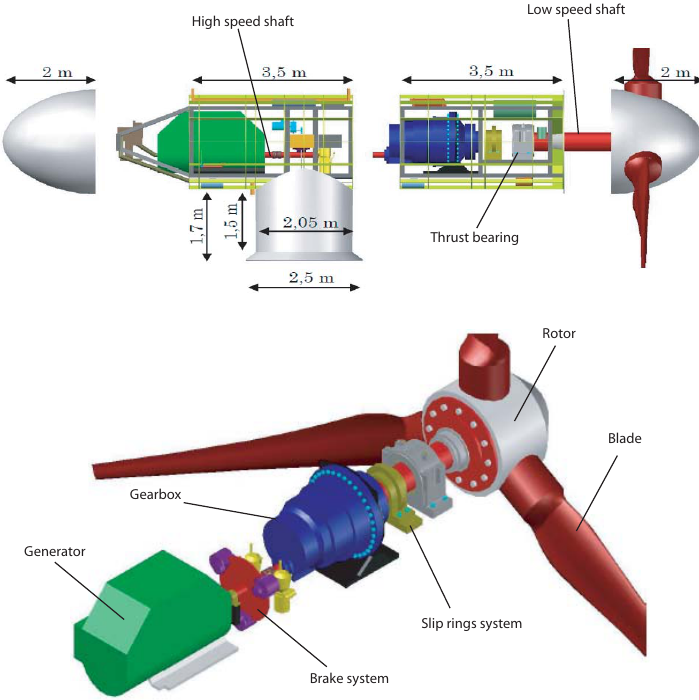
Figure 2. Distribution of the main elements within the